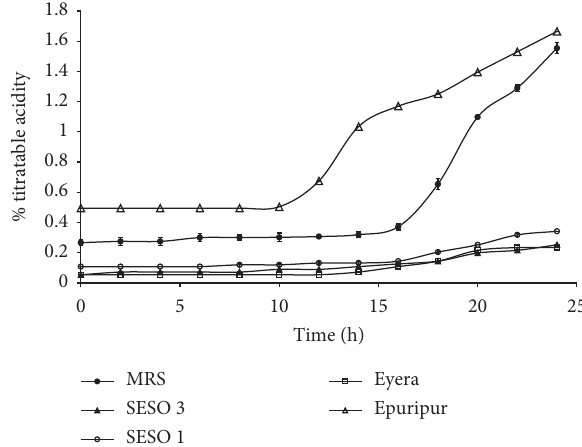
Figure 3: Changes in pH during growth of L. plantarum MNC 21 in MRS broth and malt extracts from different sorghum varieties. Error bars show standard deviations of three independent fermentations.